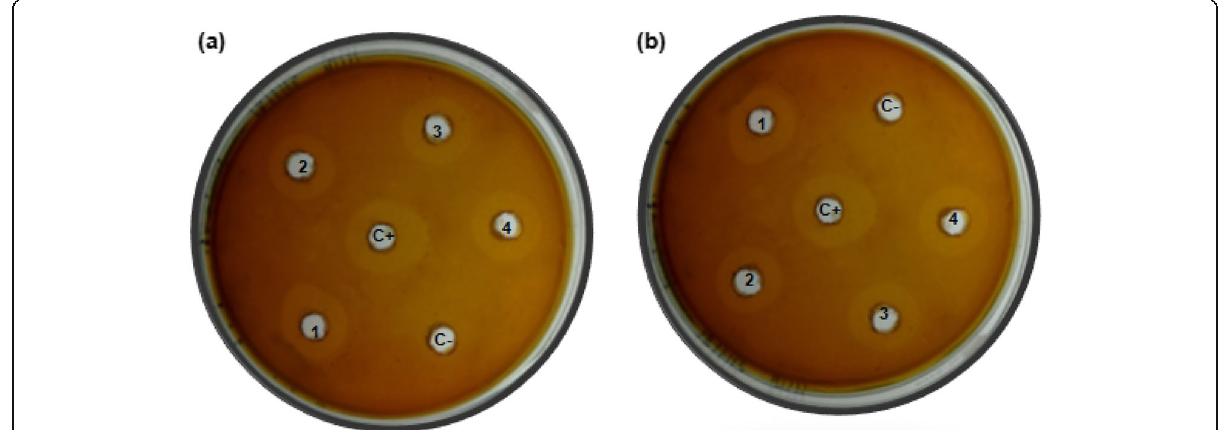
Fig. 4 Bacteriocin agar well diffusion assay showing the zone of inhibition against the indicator E. faecalis . a 1 – 4: P. acidilactici MTCC 5101 transformed with pPBT-GFP. b 1 – 4: L. brevis MTCC 1750 transformed with pPBT-GFP. C+ control native P. acidilactici MTCC 5101, C − plasmid cured P. acidilactici MTCC 5101